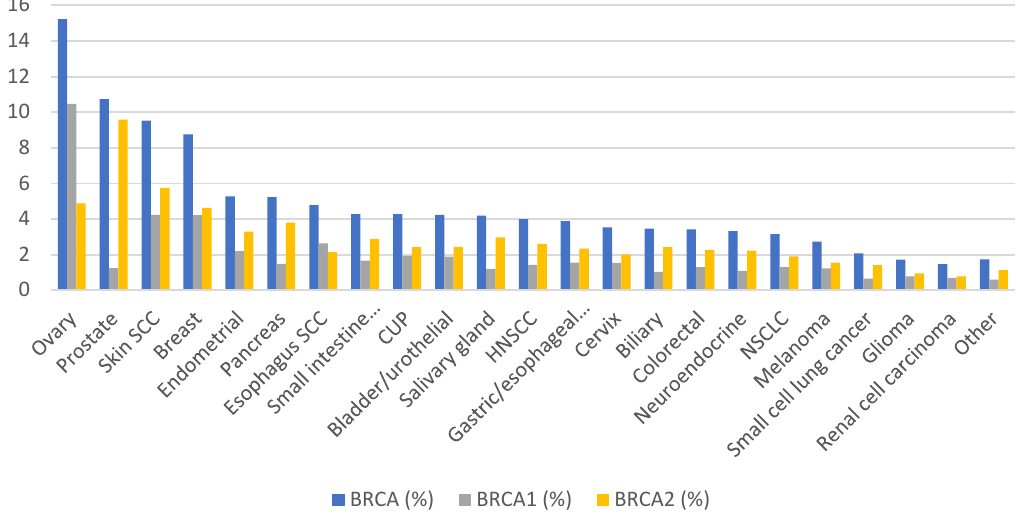
Figure 2. Prevalence of somatic BRCA1/2 mutations across different tumor types. Adapted from Sokol et al. [20], copyright 2020 the authors, American Society of Clinical Oncology under the Creative Commons Attribution Non-commercial No Derivatives 4.0 License (https://creativecommons.org/licenses/by-nc-nd/4.0/, accessed on 12 May 2022). The figure has been modified for the purposes of this review.